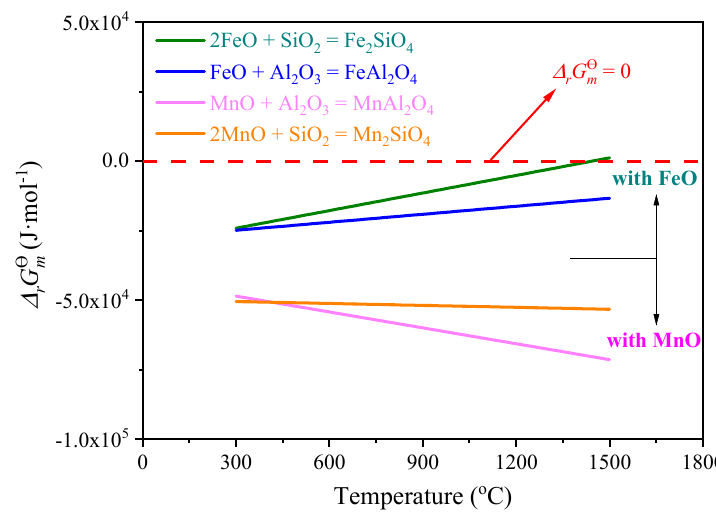
Figure 12. XRD patterns of reduced pellets with different ratio of high-maganese iron ore (HM ore) (reducing at 1050 °C for 90 min with C/Fe mass ratio of 1.5).